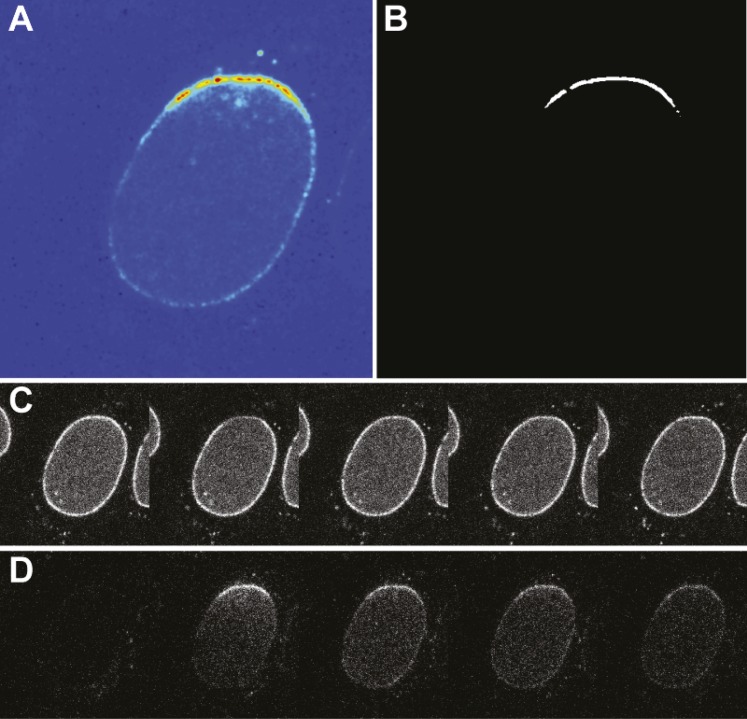
Photoconversion experiment details.(A) False-color image of the photoswitched region within a single nucleus. (B) Mask generated for photoswitched region of the nuclear envelope. (C) Timecourse of the green channel at time points: pre-photoswitch, 0, 50, 100, and 300 s. (D) Corresponding timecourse of photoswitched molecules in the red channel.